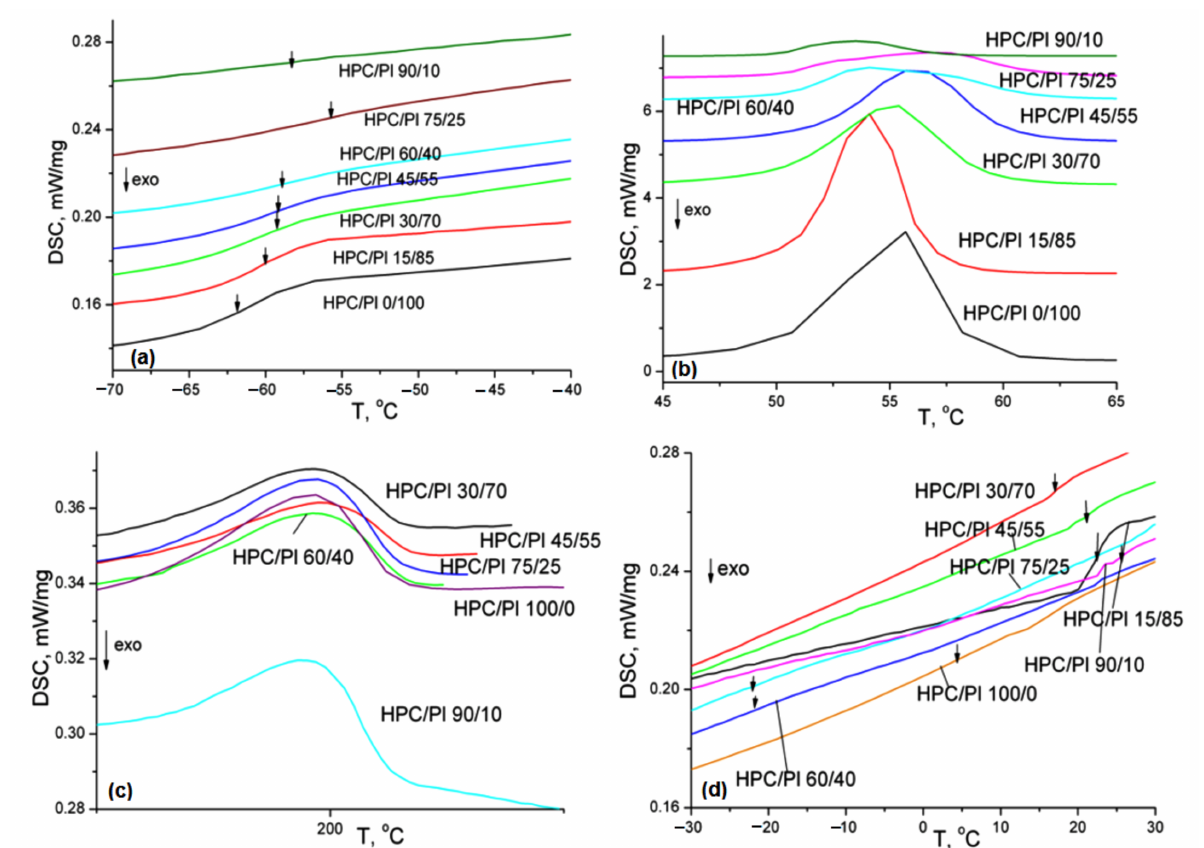
Figure 7. DSC thermograms (second heating runs) for the studied blend scaffolds: ( a ) T g1- glass transition temperature corresponding to Pluronic F68 component; ( b )T m1 -melting temperature corre- sponding to Pluronic component; ( c ) T m2 -melting temperature corresponding to HPC component; ( d ) T g2 -glass transition temperature corresponding HPC component in the blends. Table 4. Thermal characteristics obtained from the DSC (second heating run) with the hydrogel blend scaffolds.